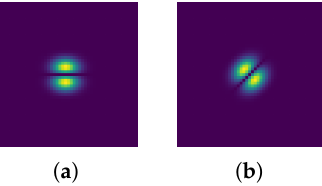
Figure 1. Gabor filter window at two angles: ( a ) θ = 0. ( b ) θ = π /4.